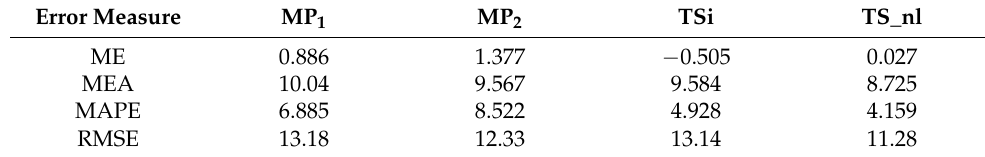
Table 6. Forecasts errors for the test